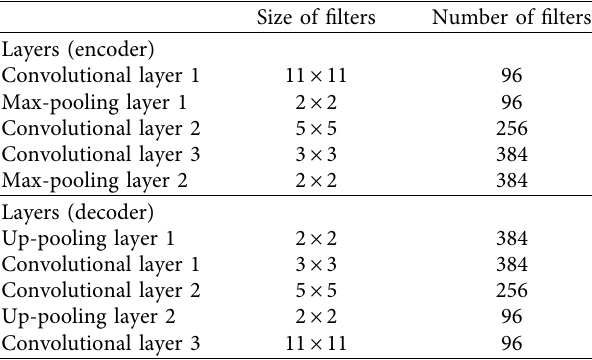
Table 5: Summary of the CAE (encoder and decoder)